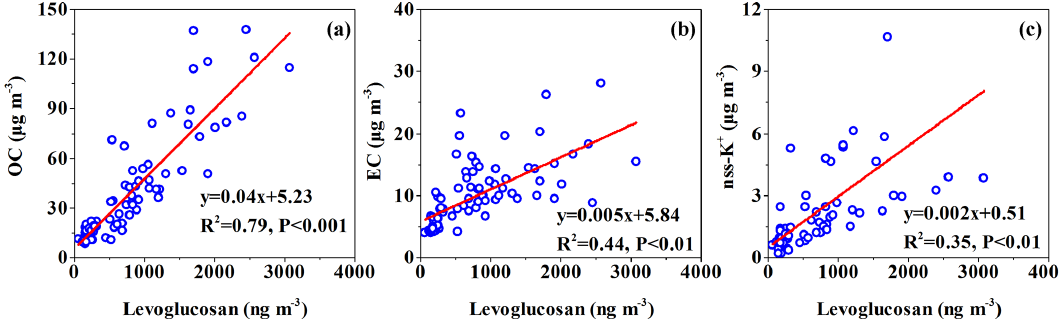
Figure 4. Correlations between (a) levoglucosan and OC, (b) levoglucosan and EC, (c) levoglucosan and nss-K + in Bode aerosols during the sampling period (April 2013–April 2014). Table 3. Linear correlation coefficients ( R 2 ) among monosaccharides and sugar alcohols in aerosols from Bode, Kathmandu Valley. Glucose Fructose Sucrose Trehalose Xylose Mannitol Arabitol Sorbitol Erythritol Glucose 1 Fructose 0.77 ∗∗∗